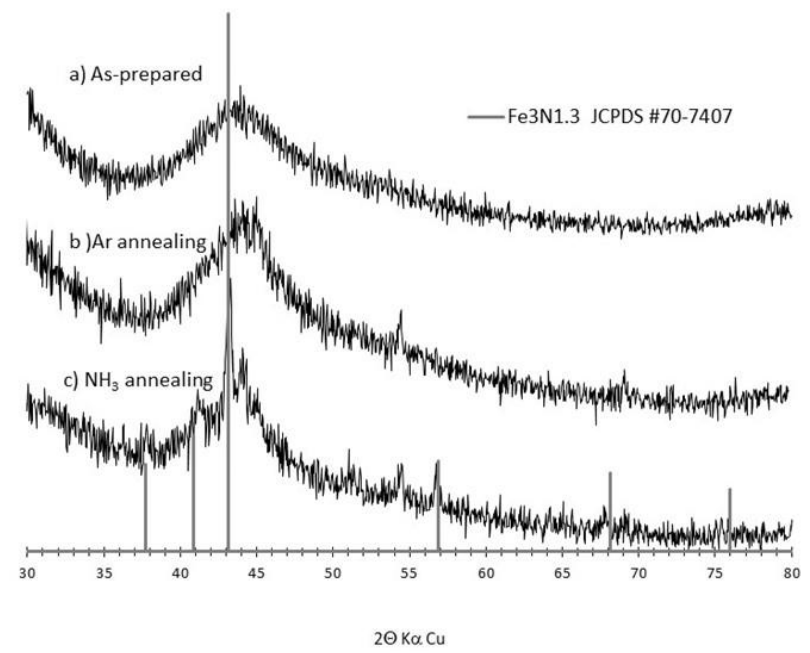
Figure 2. X-ray diffraction pattern recorded on as-formed, argon, and ammonia annealed Figure 2. X-ray di ff raction pattern recorded on as-formed, argon, and ammonia annealed materials.